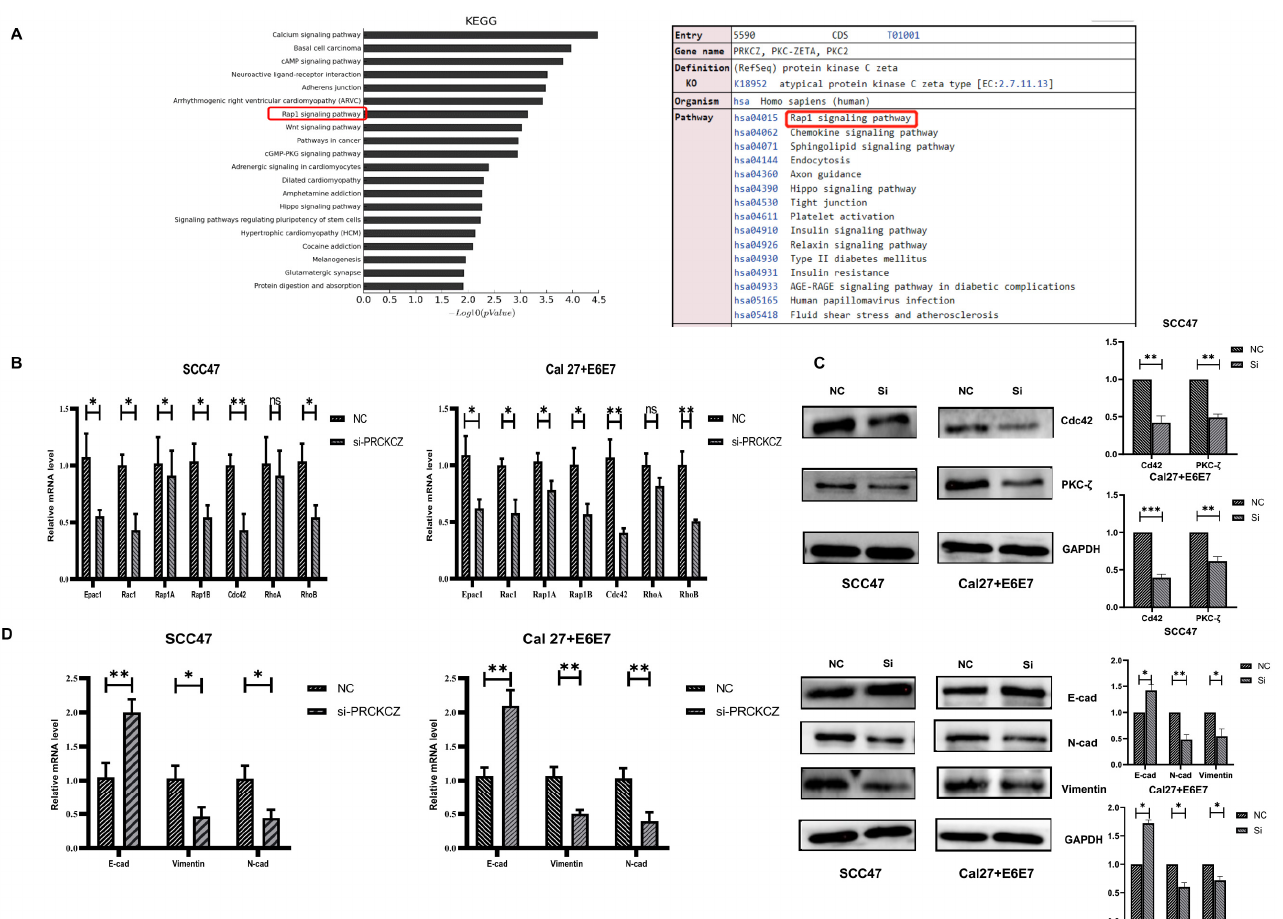
Figure 5. PRKCZ regulated Cdc42 to mediate EMT of HPV+ HNSCC cells. ( A ) The top 20 KEGG pathways for abnormal methylation gene enrichment in Illumina methylation chip and PRKCZ role in Rap signaling pathway. ( B ) The mRNA expression changes of Epac1, Rac1, Rap1A, Rap1B, Cdc42, RhoA, and RhoB in HPV+ HNSCC cells after PRKCZ silencing. ( C ) The protein expression changes of Cdc42 in HPV+ HNSCC cells after PRKCZ silencing (include densitometry analysis of WB results). ( D ) The mRNA and protein expression (include densitometry analysis of WB results) changes of E-cadherin, N-cadherin, and Vimentin in HPV+ HNSCC cells after PRKCZ silencing. All assays were carried out in triplicate. Results were presented as means ± SD. ns > 0.05, * p < 0.05, ** p < 0.01, *** p <